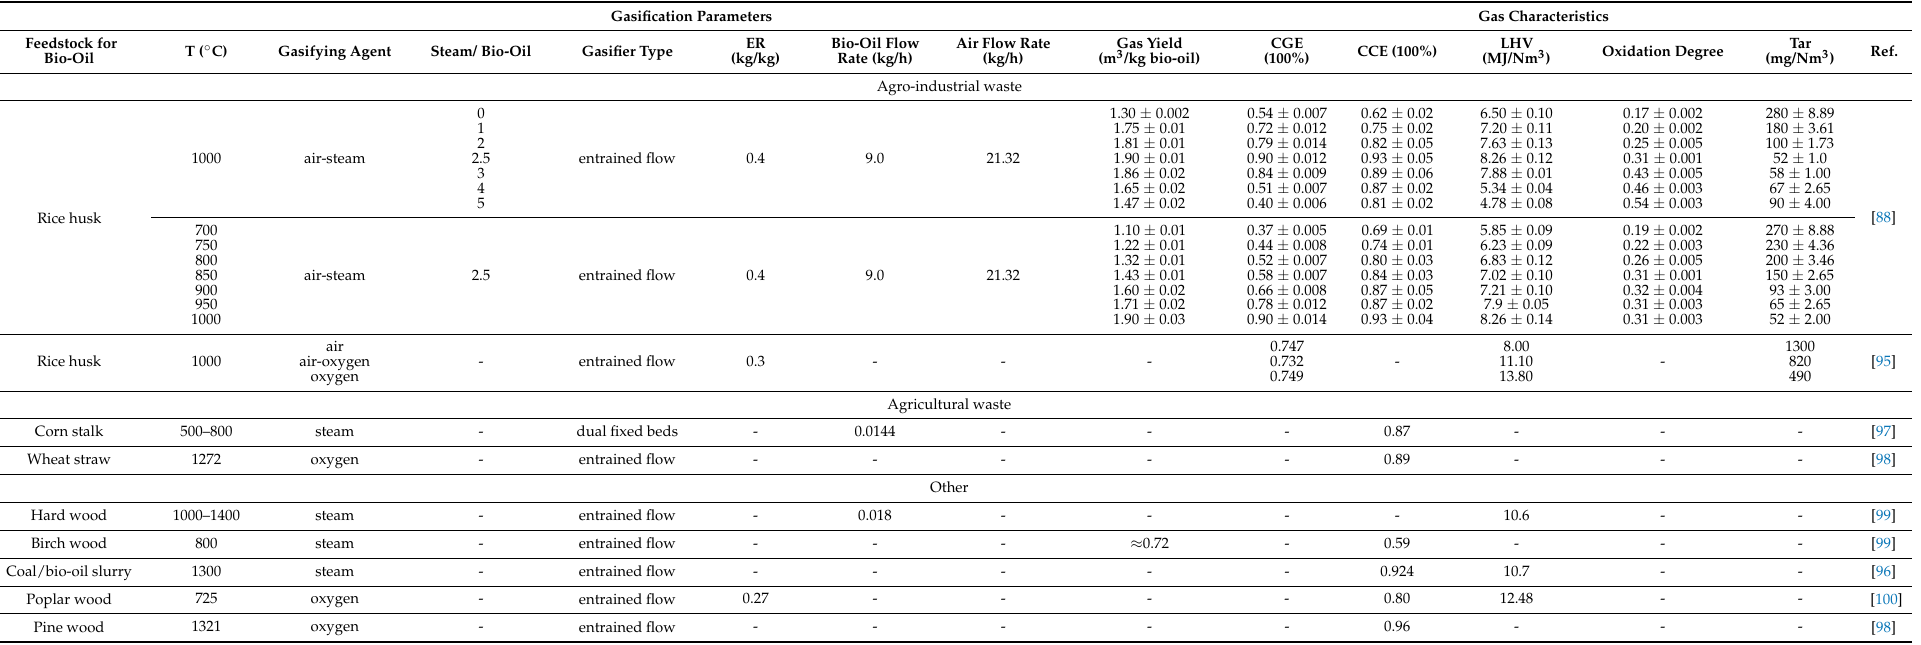
Table 10. Effect of bio-oil gasification parameters on the produced